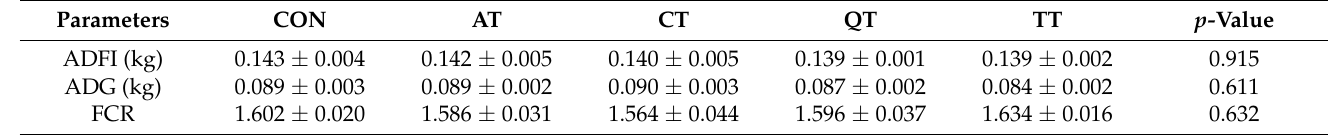
Table 3. ADFI, ADG and FCR of